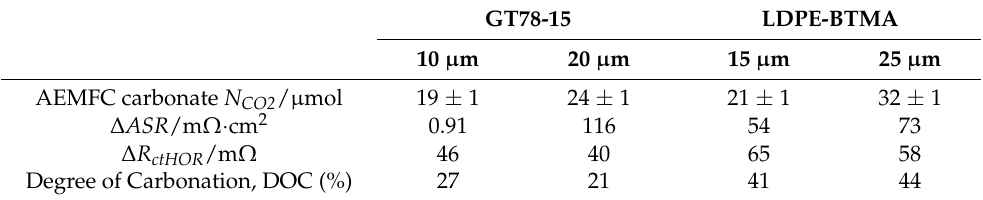
Table 2. Degree of steady-state carbonation as function of AEM thickness of GT78-15 and LDPE- BTMA AEMs feeding with 400 ppm CO 2